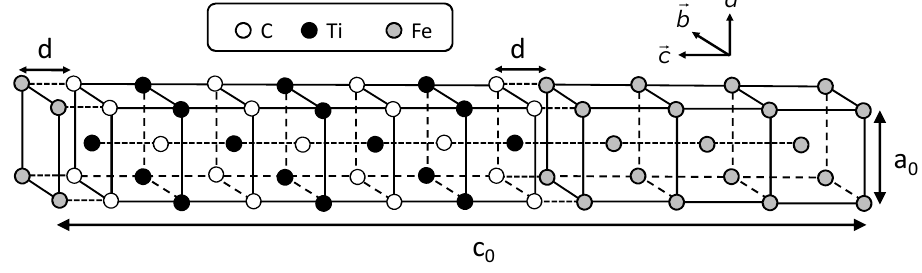
Figure 1. Arrangement of atoms in the coherent interface with 14 layers along the c-axis.